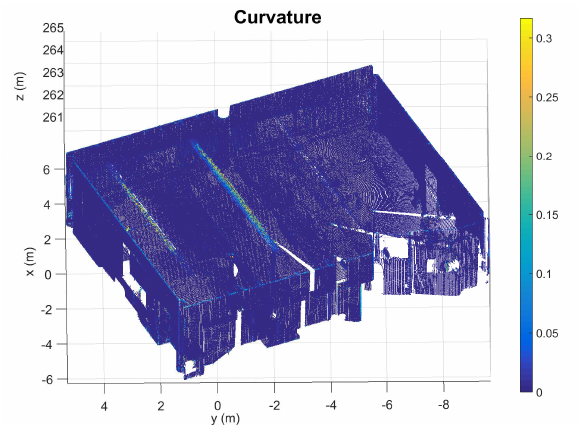
Figure 3. Classroom point cloud coloured with the change of curvature values.